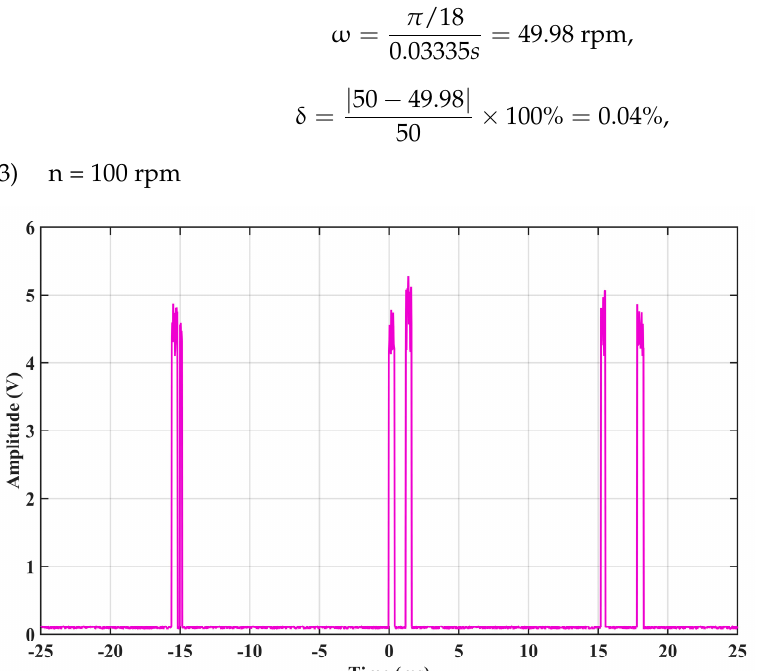
Figure 3. The 50 rpm oscilloscope waveform.